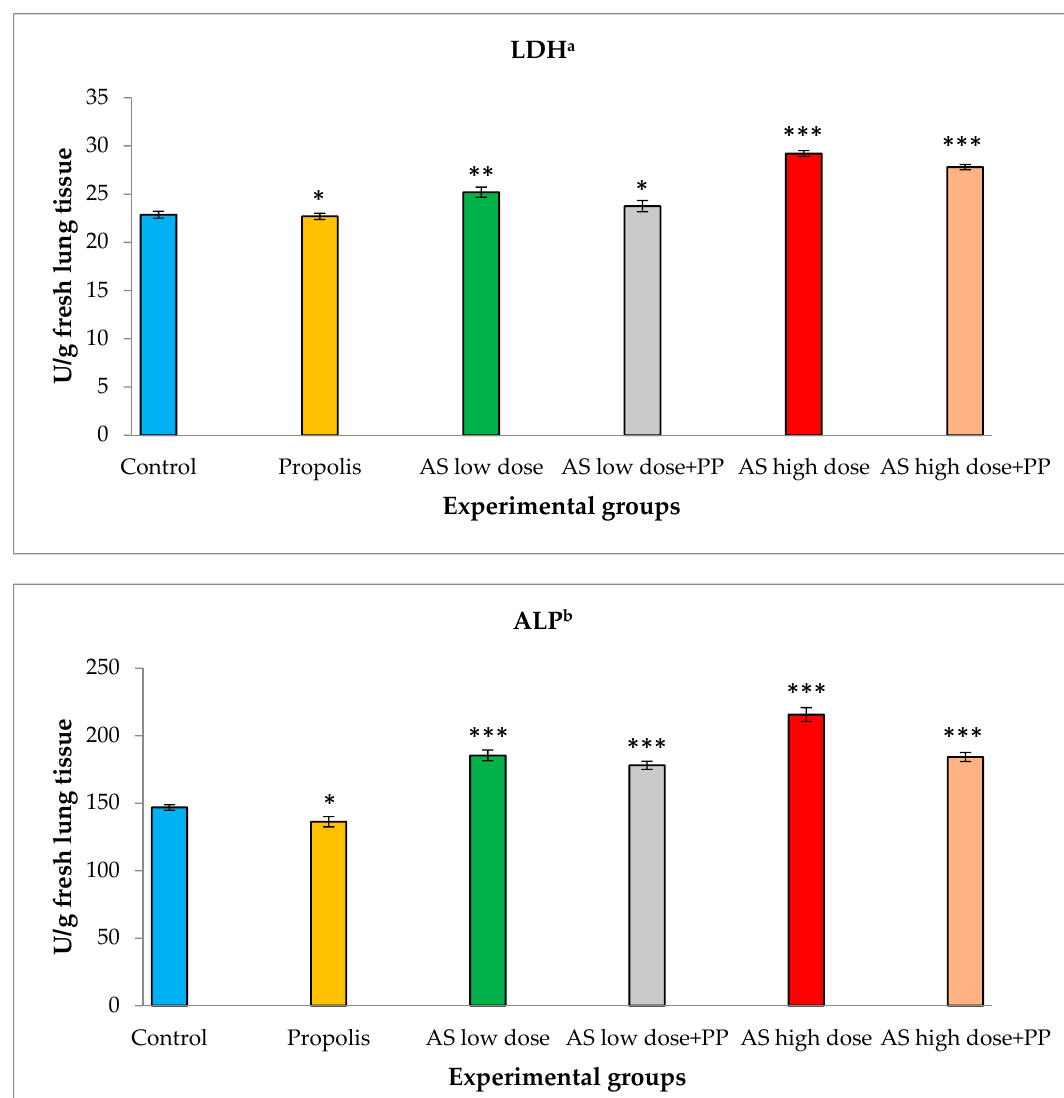
Figure 1. Estimation of biochemical oxidative stress in rat lungs in the different animal groups: ( a ) glutathione reductase (GSH); ( b ) superoxide dismutase (SOD); ( c ) glutathione s-transferase (GST). *— Non-significant, **—Significant, ***—Highly significant.